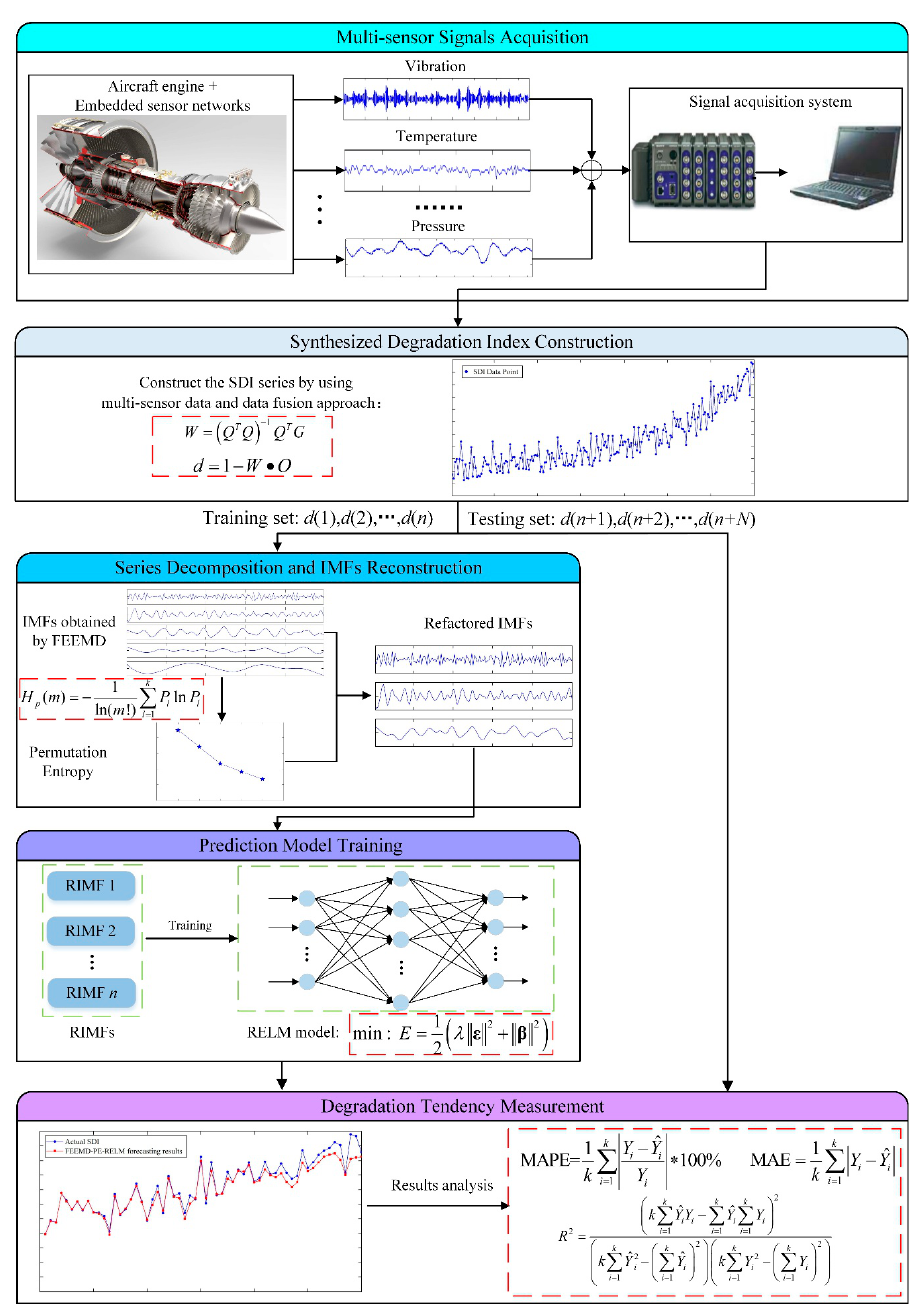
Figure 2. The flowchart of the proposed degradation tendency measurement method.